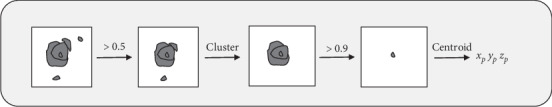
Overview of the postprocessing step depicted in 2D for clarity. From the averaged volume, the points with values higher than 0.5 were clustered. The largest cluster was selected, and from the points with values higher than 0.9, the centroid was computed. This centroid was used as the predicted 3D point.